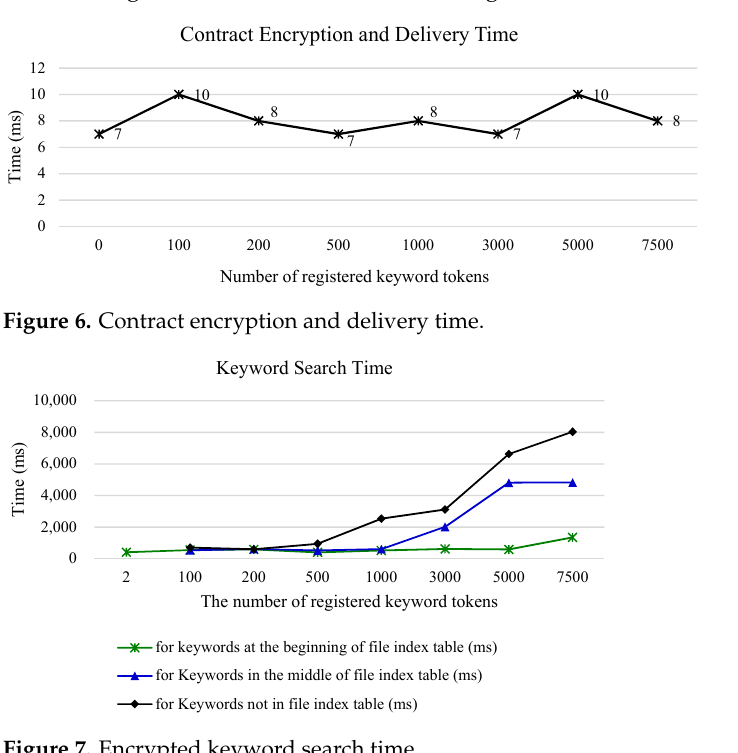
Figure 7. Encrypted keyword search time.